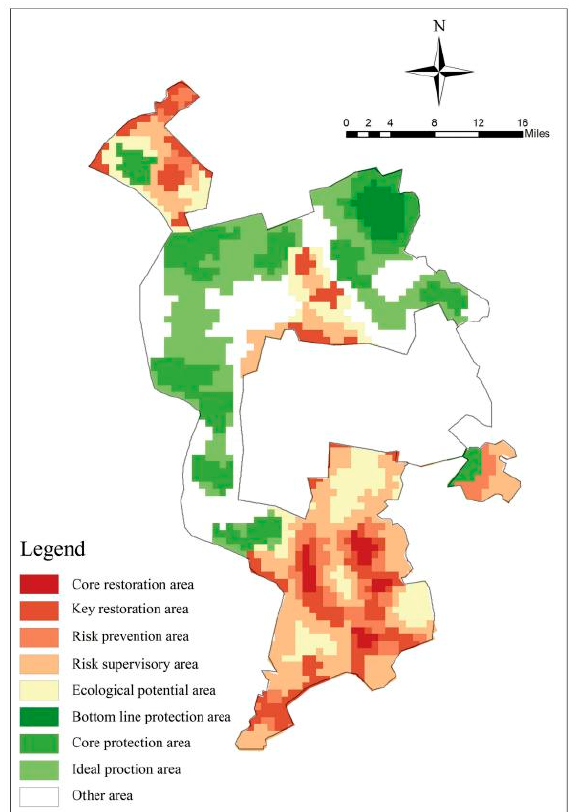
Figure 12. Time–space overlay analysis.